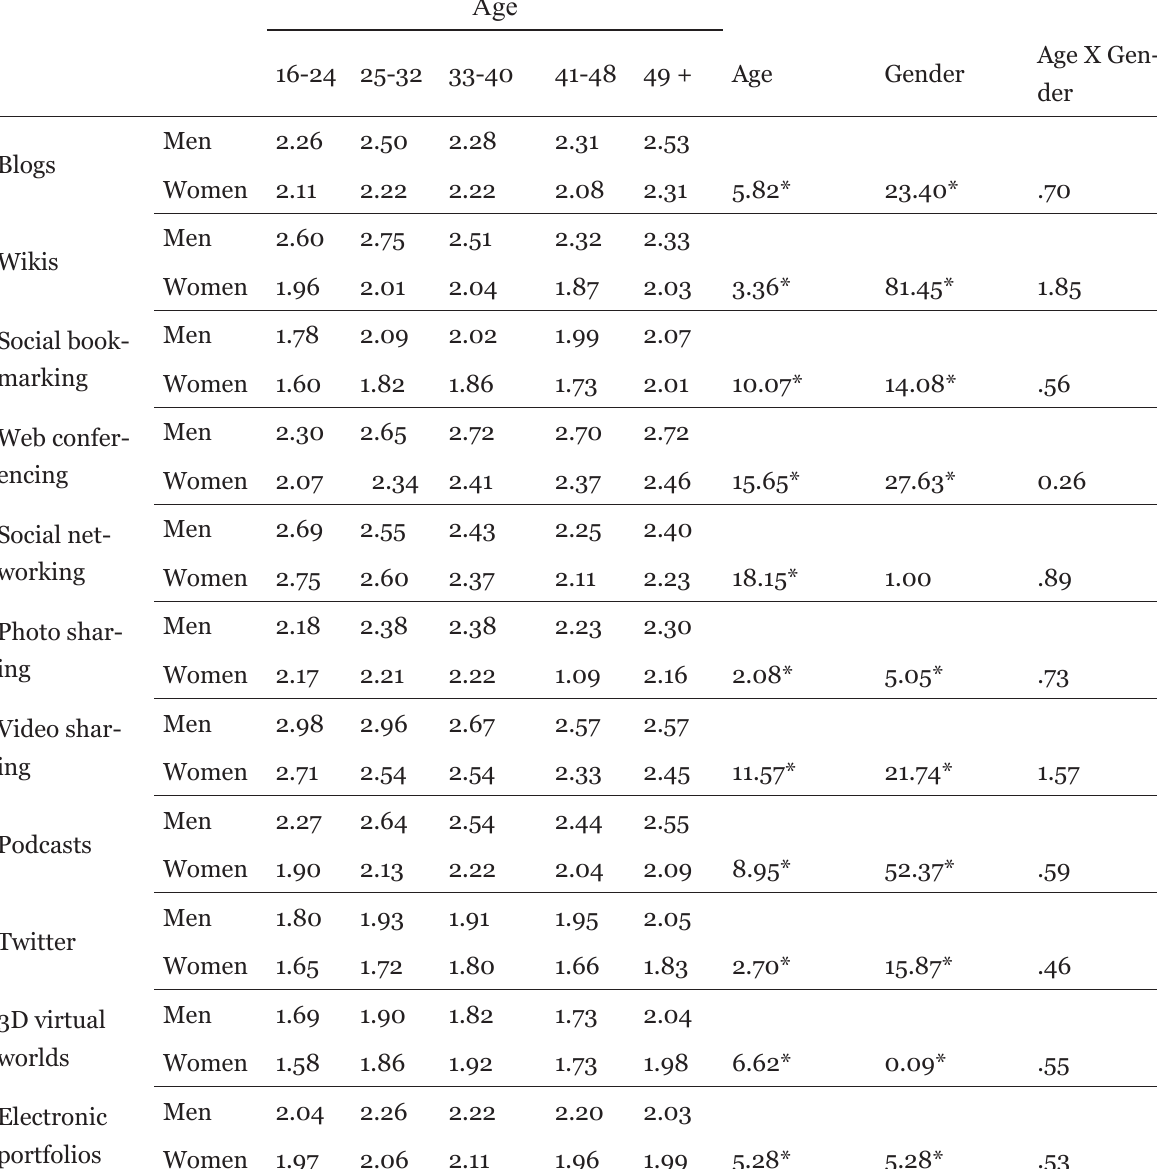
Table 8 Interest in Using Social Software to Learn by Age and